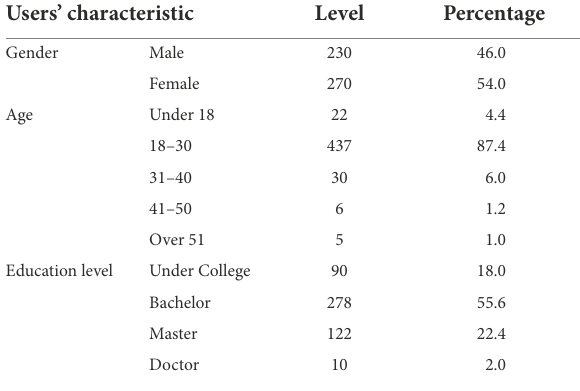
TABLE 1 Demographic characteristics of the survey